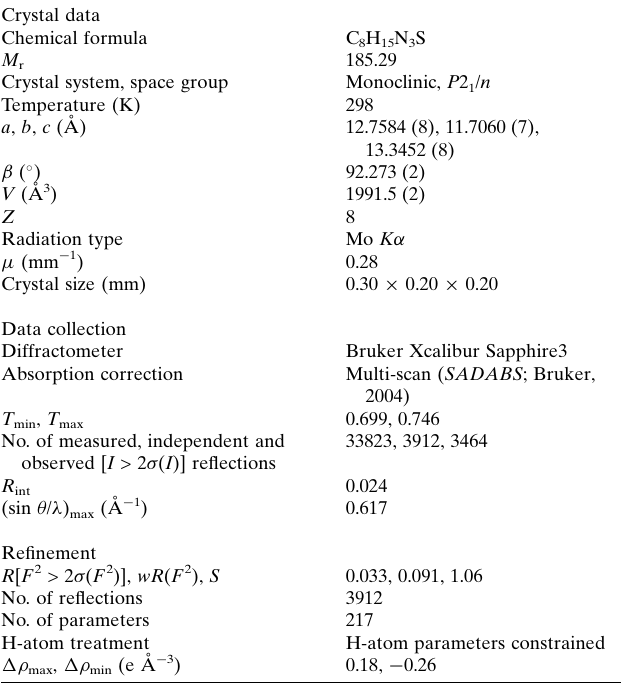
Table 2 Experimental details. Crystal data Chemical formula